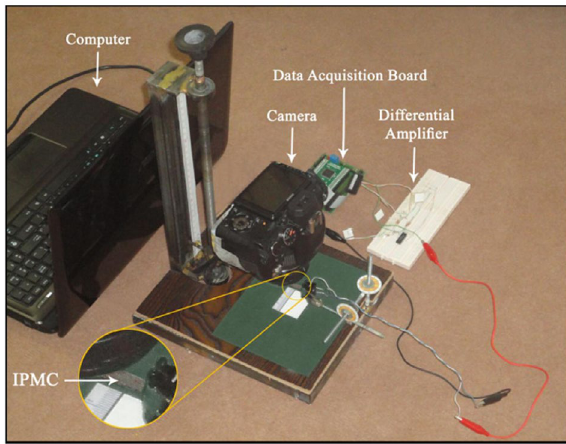
Figure 5. The photograph of hardware apparatus 9 .